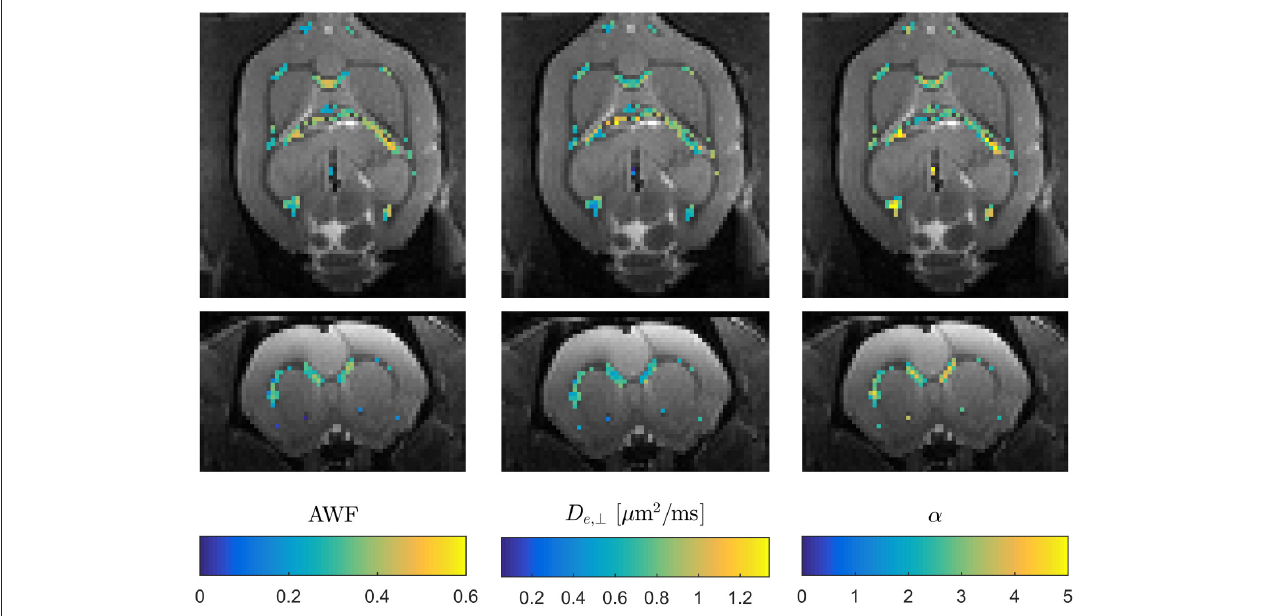
FIGURE 6 | Example of three WMTI parameters mapped in an in vivo rat brain using axisymmetric WMTI analysis of a 1-9-9 data set. Parameters are shown mapped onto b 0 data in two orthogonal slice orientations. Data was acquired at 300 µ m isotropic =